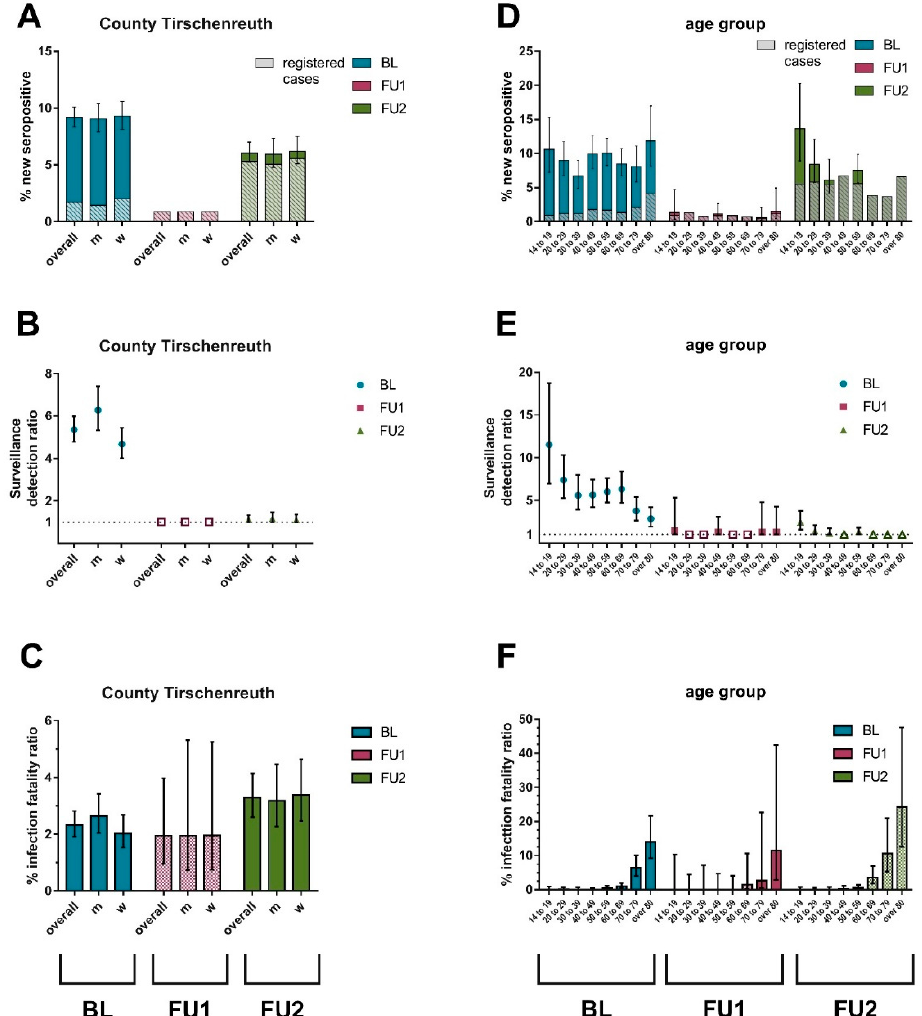
Figure 3. Standardized (N-based) new seropositivity, surveillance detection ratio (SDR), and infection fatality ratio (IFR) for Baseline (BL), Follow up 1 (FU1) and Follow up 2 (FU2). Shown are new seropositivity (based on N-antibodies) (%) and new registered case incidence (%), the surveillance detection ratio (SDR) and infection fatality ratio (IFR) (%) in the county population overall ( A – C ) and by age-groups ( D – F ). Non-solid coloring of symbols or bars ( B , C , E , F ) represents derived estimates from registered cases rather than serology, when registered cases exceeded the number of expected infections in the county based on serology. Error bars represent 95% confidence intervals (95%-CI, A , D ) or 95% credibility intervals ( B , C , E , F ), respectively. The % ever seropositives at the respective observation periods at BL, FU1 and FU2 was 9.18% [95%-CI 8.34–10.09], 9.97% [95%-CI 9.03–11.01] and 15.43% [95%-CI 14.25– 16.69], respectively (Supplementary Figure S1 and Supplementary Table S5).